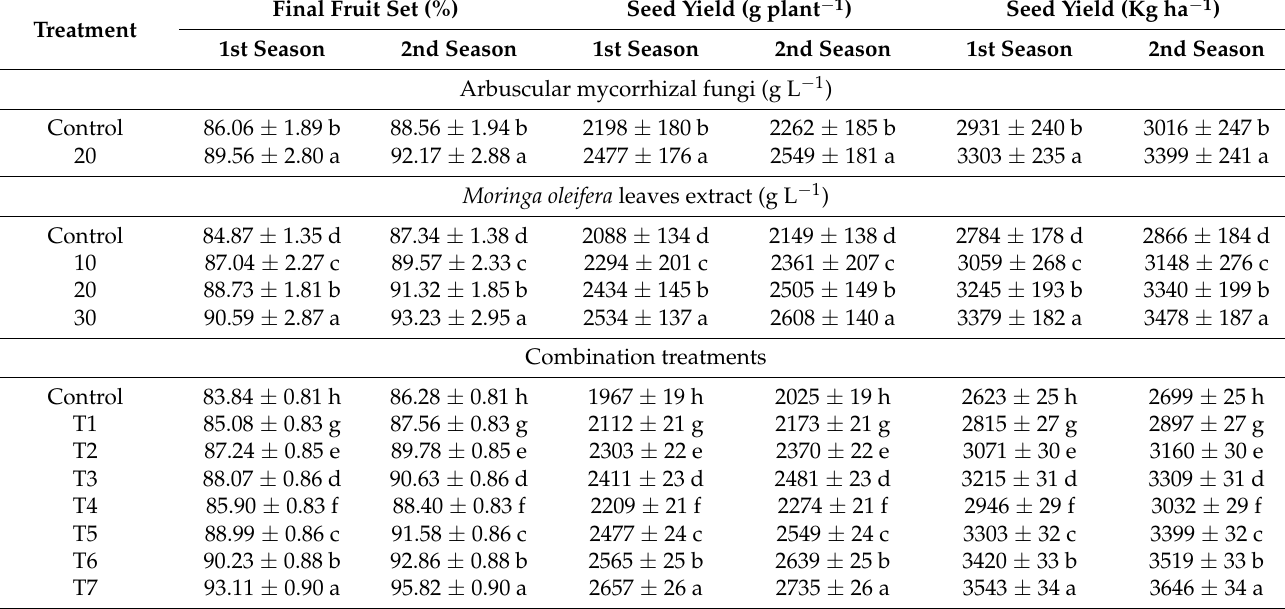
Data are mean value ± SE. Means in columns followed by the same letter are not statistically different at the 0.05 significance